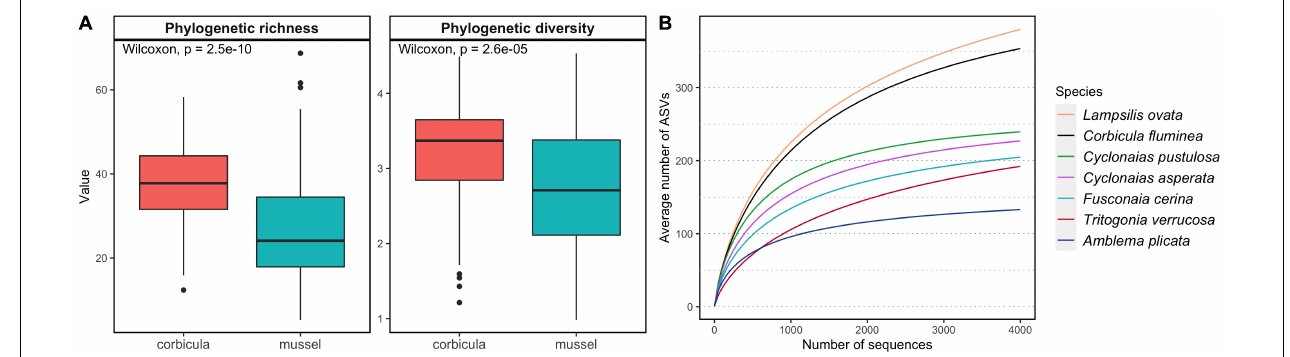
FIGURE 2 | Alpha diversity of the gut microbiomes of six native freshwater mussel species and the invasive clam Corbicula fluminea , collected from six rivers in the Tennessee and Mobile River Basins, United States. (A) Distribution of phylogenetic richness (Faith’s PD) and phylogenetic diversity (Allen index of diversity) in C. fluminea and mussels. (B) Average accumulation curves representing the number of amplified sequence variants (ASVs) in random subsamples of 1 to 4000 sequences per sample. Other descriptors of alpha diversity and coverage are available in S2- Supplementary Table 1